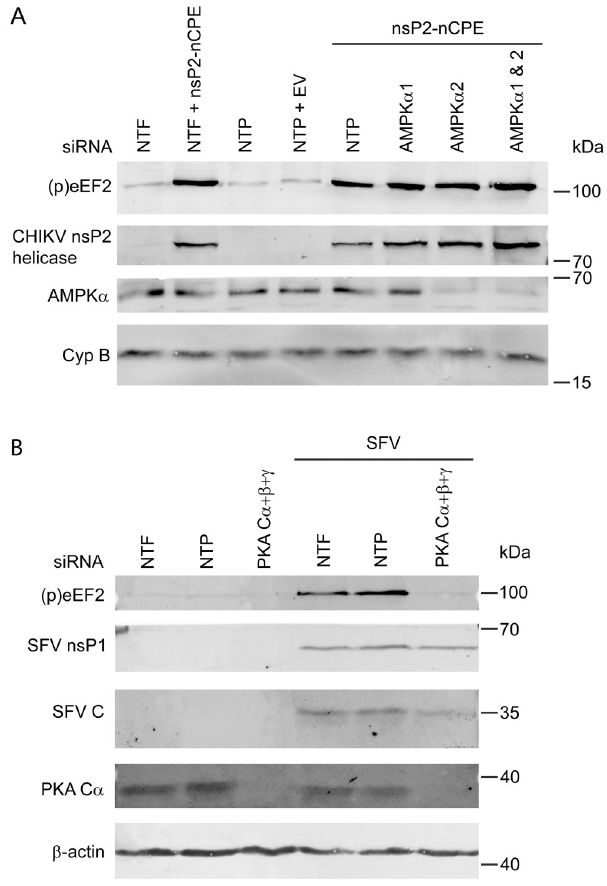
Fig 8. CHIKV nsP2-induced phosphorylation occurs independent of AMPK. (A) Vero E6 cells were transfected with siRNAs targeting the catalytic subunit isoforms of AMPK. A non-targeting pool (NTP) of siRNAs was used as a control. 2 d p.t. the cells were transfected with pCAGGS-IRES-nsP2-nCPE and harvested 18 h p.t. An empty vector transfection and non-transfected cells (NTF) were included as controls. nsP2, (p)eEF2 (T56), and AMPK α were detected by WB. A representative blot is shown of 3 independent replicates. (B) Vero E6 cells were transfected with siRNAs targeting the catalytic subunits of PKA. A non-targeting pool (NTP) of siRNAs and non-transfected cells (NTP) were used as a control. 3 d p.t. the cells were infected with SFV MOI 1 and harvested 6 h p.i. (p)eEF2, nsP1, PKA and C were detected by